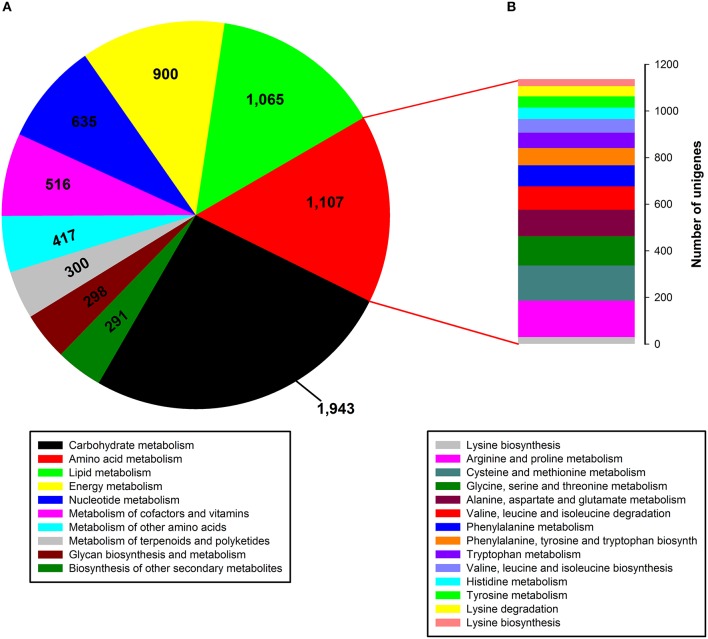
Pathway assignment based on KEGG. (A) Classification based on metabolism categories; (B) Classification based on amino acid metabolism categories.